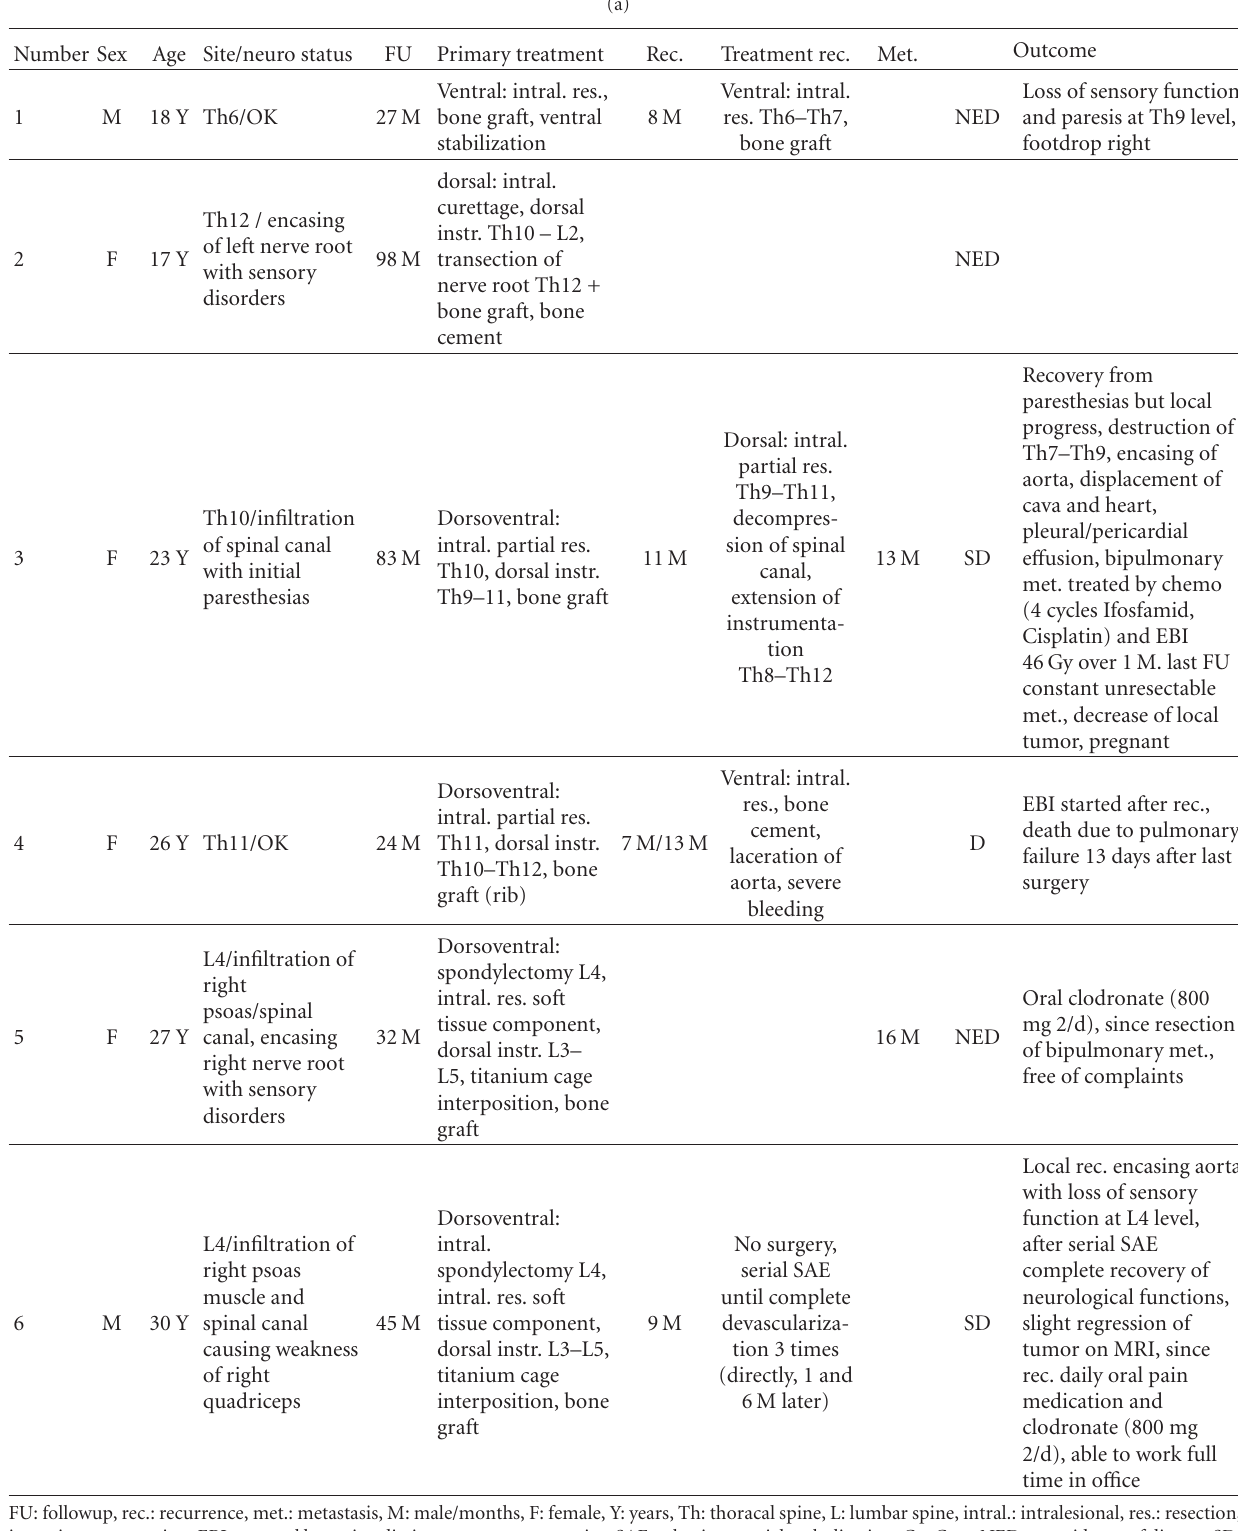
Table 1: (a) Giant cell tumors of the mobile spine. (b) Giant cell tumors of the